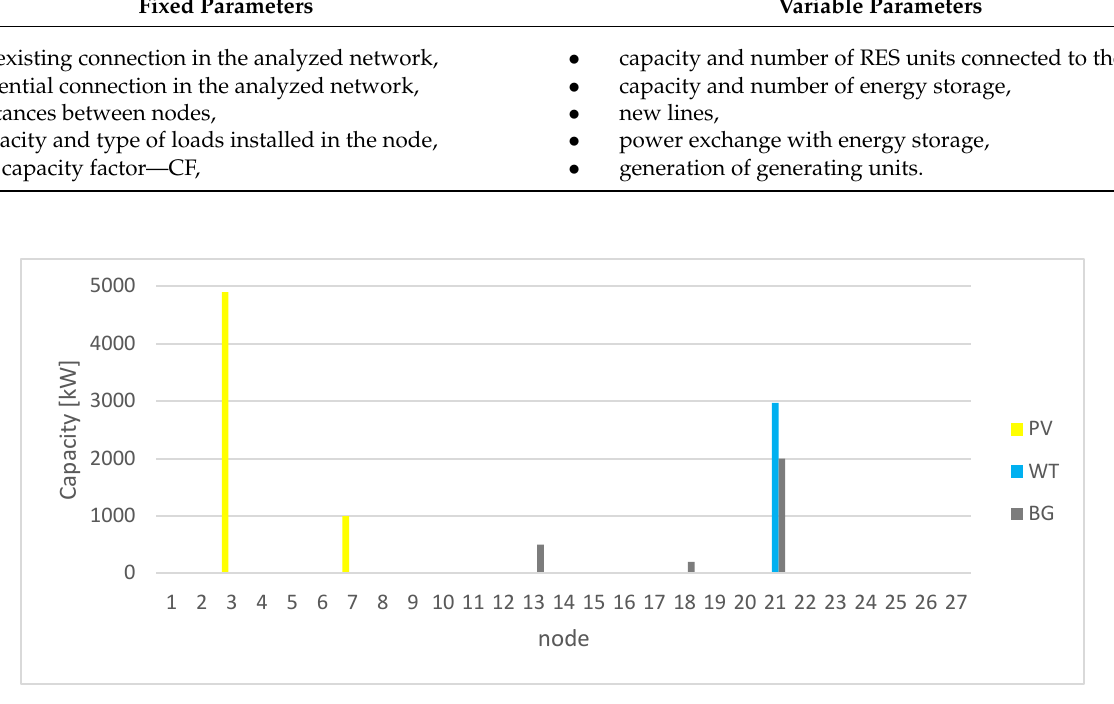
Figure A3. Capacity structure for scenario “2”. Figure A4. ES capacity structure for scenario “2”.